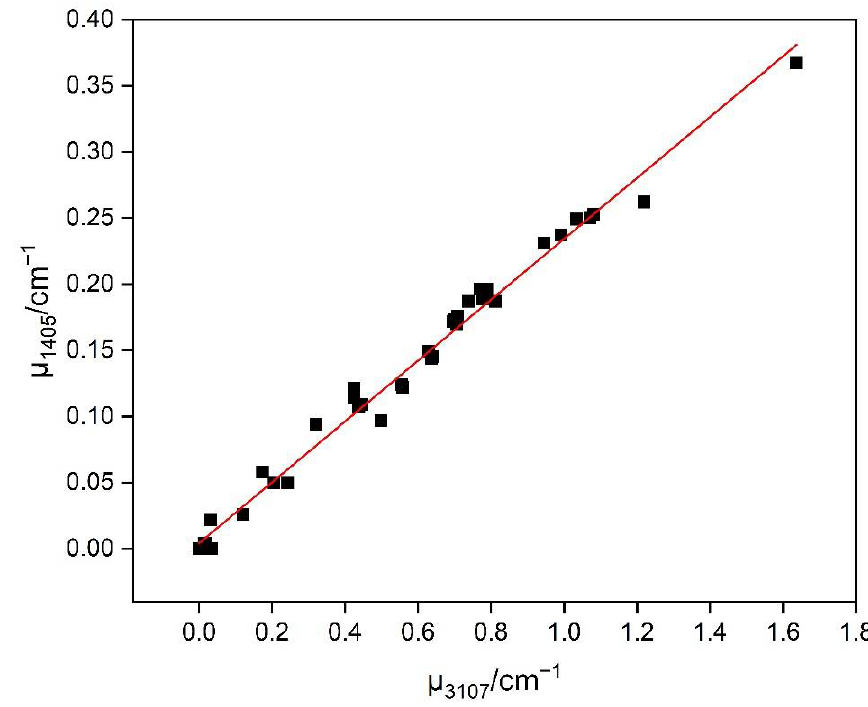
Figure 3. μ1405 as a function of μ3107, the gradient is about 0.23, and the data displayed here are Figure 3. µ 1405 as a function of µ 3107, the gradient is about 0.23, and the data displayed here are calculated from 38 natural diamond samples containing isolated nitrogen we studied, which can detect an obvious 3107 cm − 1 absorption